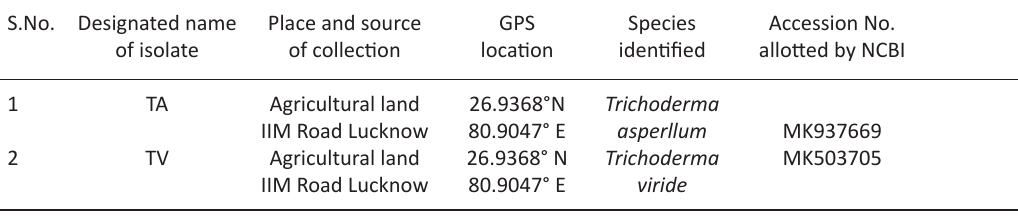
Table 3. Details of molecular characterization of TS isolates